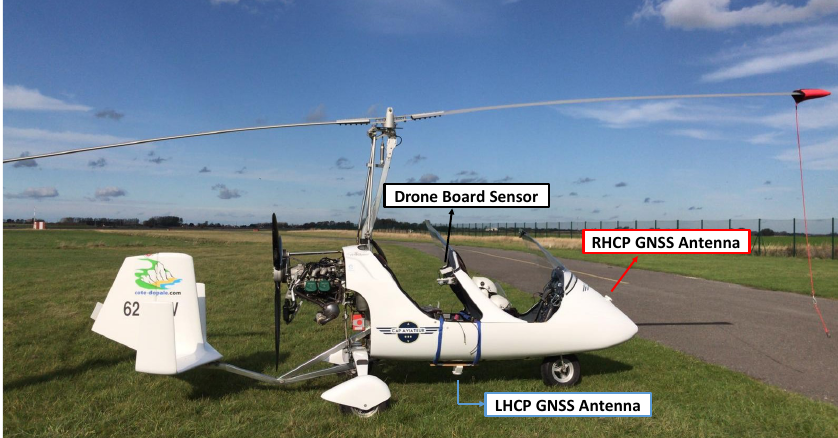
Figure 10. The gyrocopter that was used during the flight with the sensors embedded on it. An RHCP antenna is fixed on the nose of the gyrocopter pointing towards the zenith and an LHCP antenna is mounted on the bottom of the gyrocopter pointing towards the nadir. A drone board sensor records the receiver’s attitude, altitude and position with respect to the GPS time. In addition to the on-board sensors, the gyrocopter was loaded with the necessary setup that constitute the GNSS-R receiver hardware for data collection. This receiver is composed of a delay line, combiners/splitters and a Syntony L1-L5 bit grabber for digitizing the composite